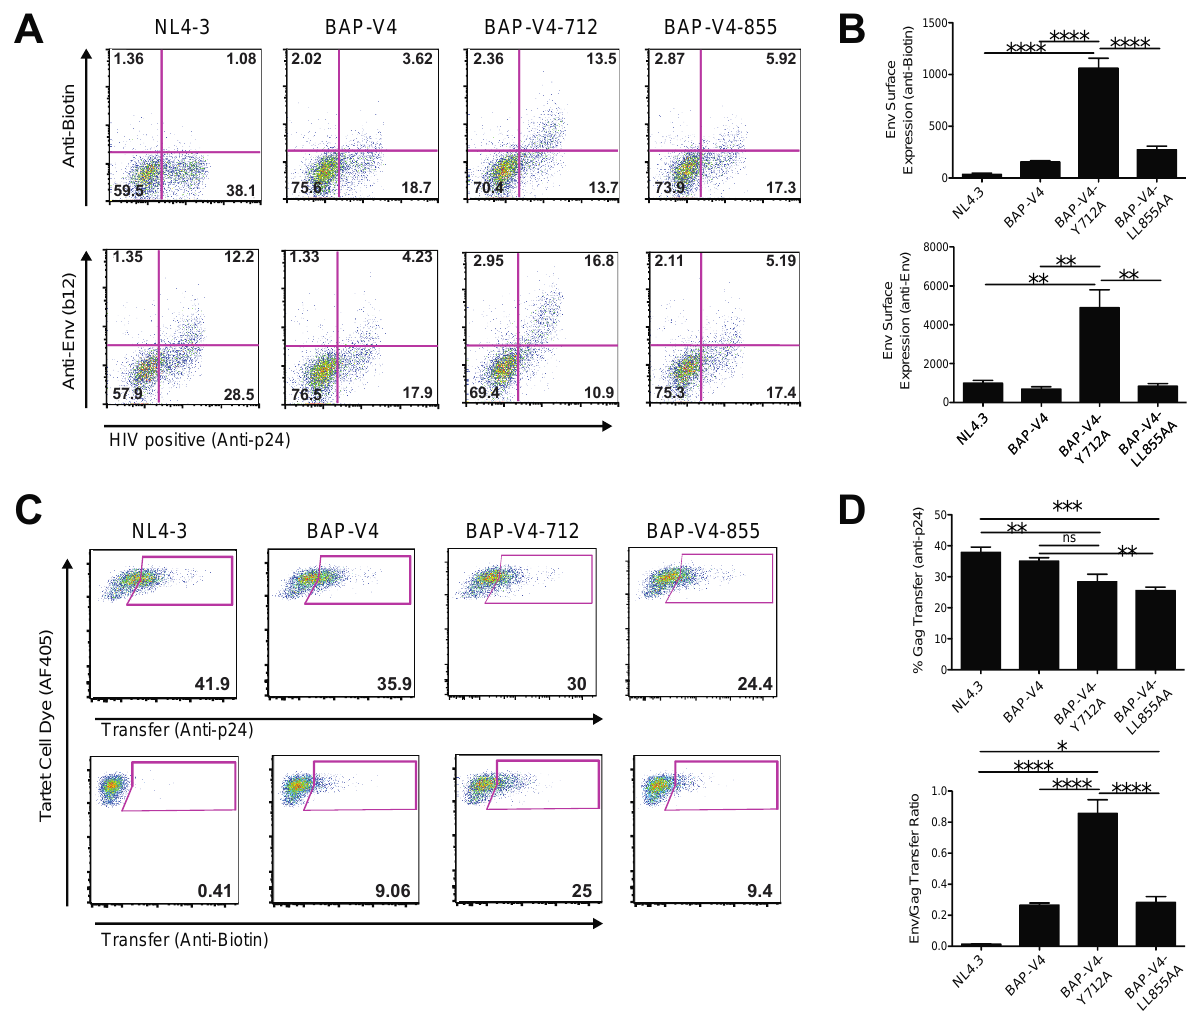
BAP-V4 558-4V-PAB217-4V-PAB3-4LN